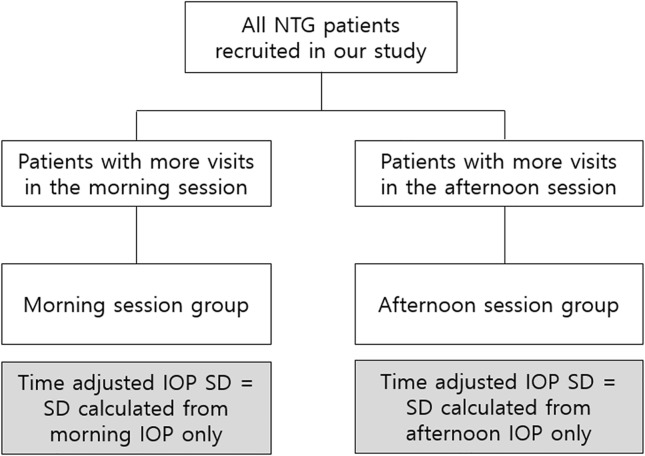
The selection method of patients based on more frequently visited session of time.Intraocular pressure (IOP) was divided into morning session (9 am-12 pm) and afternoon session (1 pm-5 pm) values. We identified a session with more frequent visit for each patient during the follow-up period, either morning or afternoon. The IOP and standard deviation of IOP measured during the selected session was defined as ‘time adjusted IOP’ and ‘time adjusted IOP SD’, respectively.